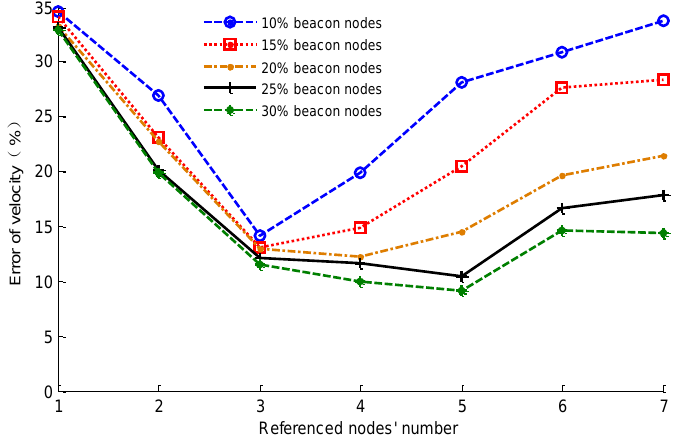
Figure 7. The relationship of velocity error and M.